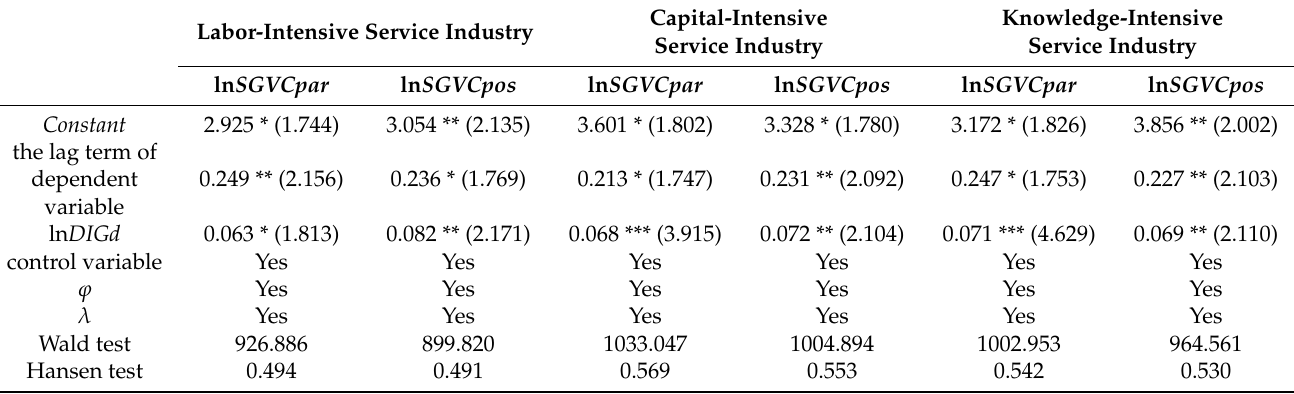
Table 6. Results of heterogeneity test